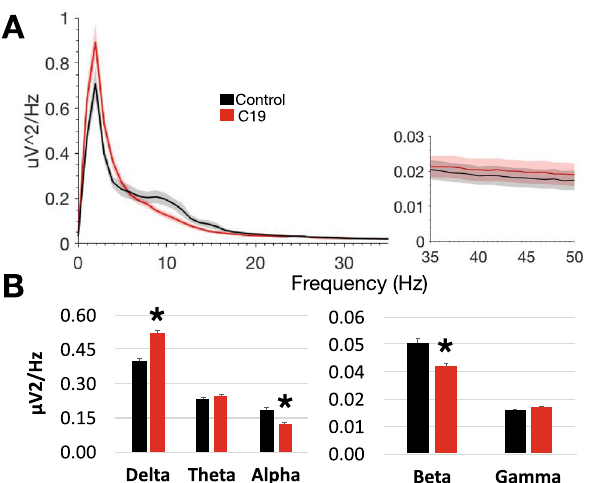
Figure 1. ( A ) Power spectral density (mean of 16 EEG channels) in age-matched control and C19 subjects (n = 30 per group) in the 0–50 Hz frequency range. ( B ) Mean power in the frequency bands delta (1–4 Hz), theta